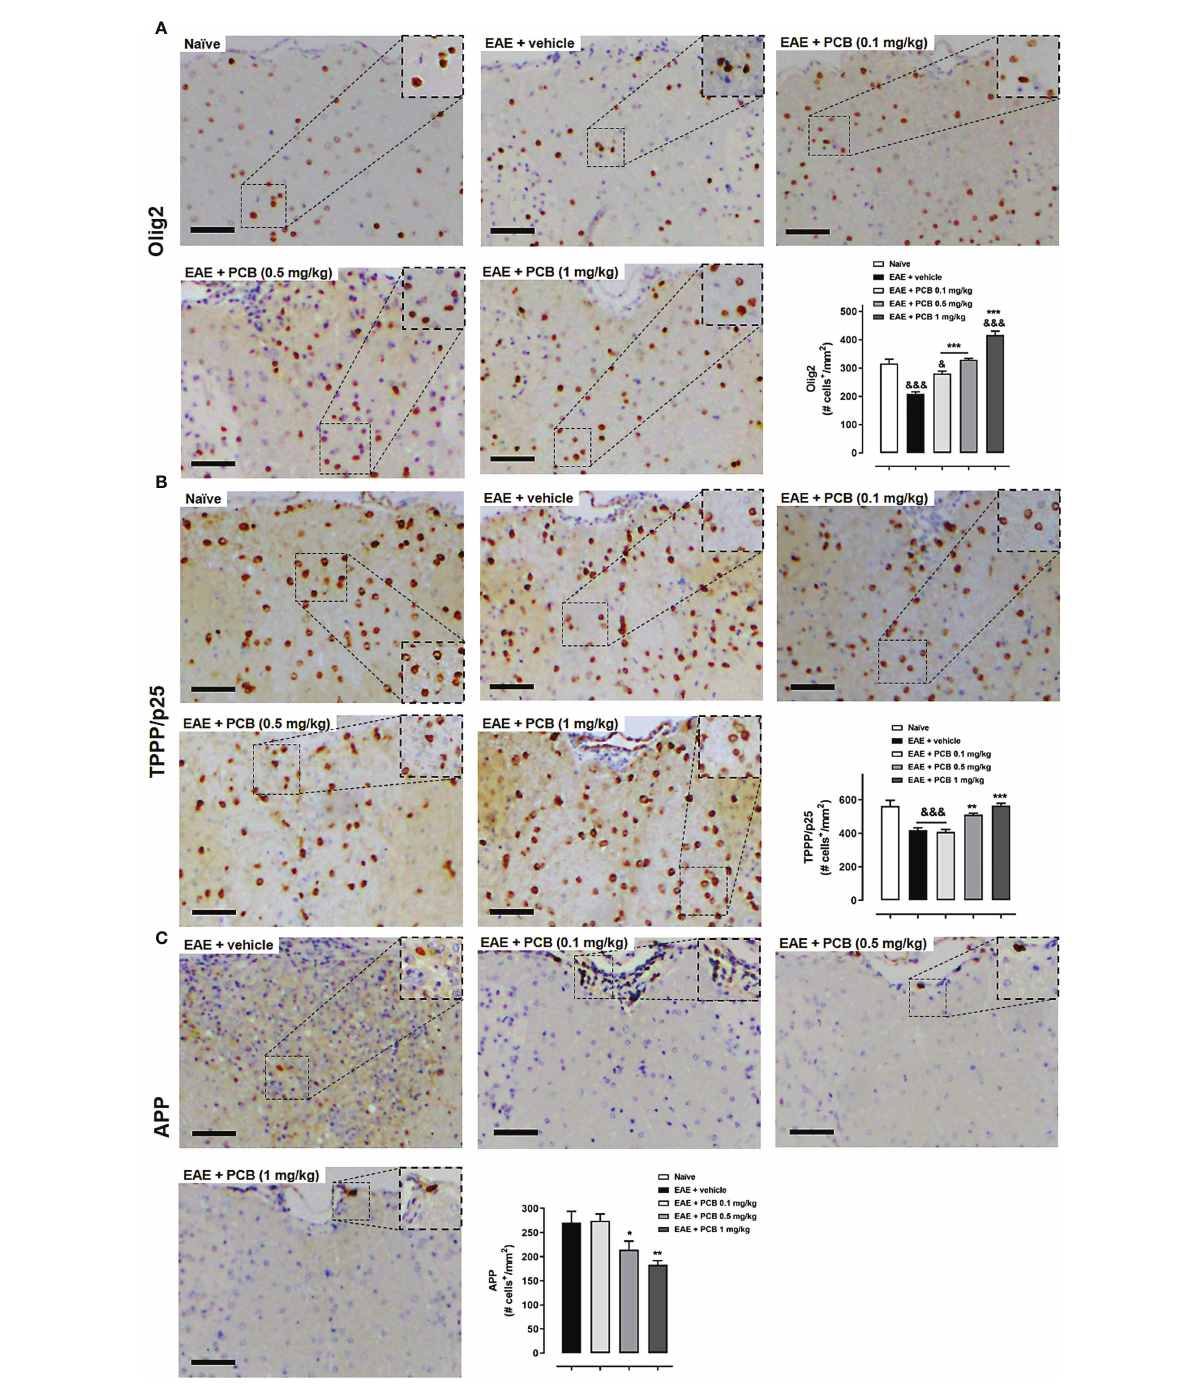
FIGURE 5 Immunohistochemical assessment of the PCB effects on oligodendrocyte and neuronal markers in spinal cords of EAE mice. The representative cross-sectional images and the respective morphometric evaluation per variable are shown in each panel. (A) Oligodendrocytes precursor cells (Olig2). (B) Mature oligodendrocytes (TPPP/p25). (C) Acute axonal damage (APP). MOG 35 – 55 immunized mice received a daily i.p. injection of PBS (vehicle) or PCB at 0.1, 0.5 or 1 mg/kg, from day 0 until day 26 post-immunization. The cell densities (number of positive marked cells per mm 2 ) were calculated by dividing with total area of the white matter in transversal sections. Data are expressed as mean ± SEM (n=4-7 per group). The ampersand (&) and asterisk (*) are indicative of signi fi cant differences with non-immunized naïve and vehicle-treated EAE mice, respectively (*p<0.05, **p<0.01, ***p<0.001; & p<0.05, &&& p<0.001, ANOVA + Newman-Keuls tests). Bar: 50 m